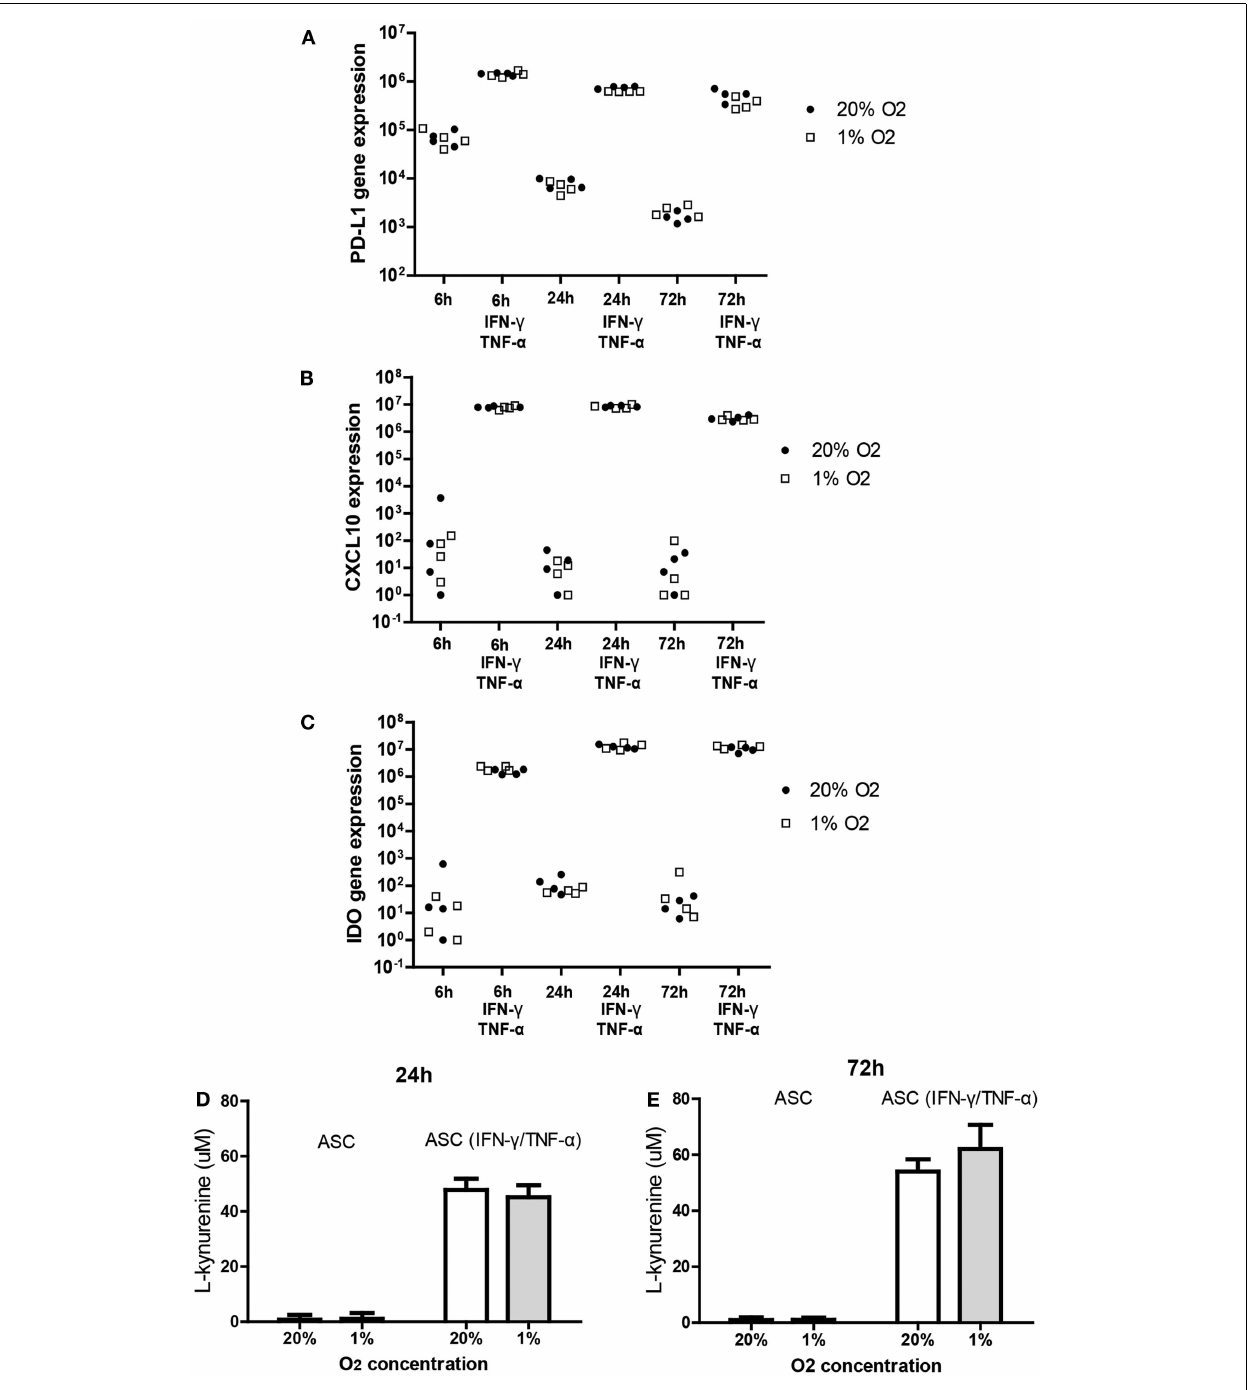
a distinct ASC culture ( n = 4 different ASC cultures). (D,E) IDO activity determined by accumulation of L -kynurenine in ASC conditioned medium in the absence and presence ofTNF and IFN [24h (D) and 72h (E) ]. Means of five ASC cultures with SEM shown.